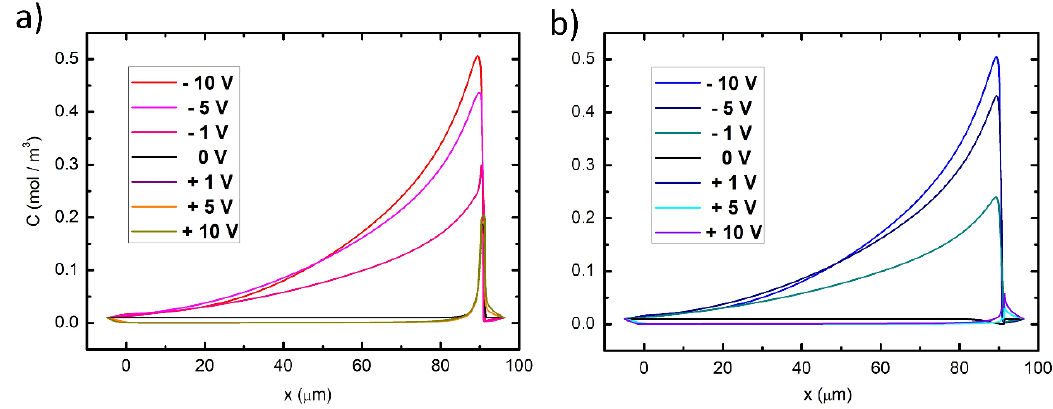
Figure 5. K + ( a ) and Cl − ( b ) ion concentration along the longitudinal section of the funnel and nanochannel as a function of the applied voltage between the reservoirs (C Bulk = 10 −5 M = 10 −2 mol/m 3 ).